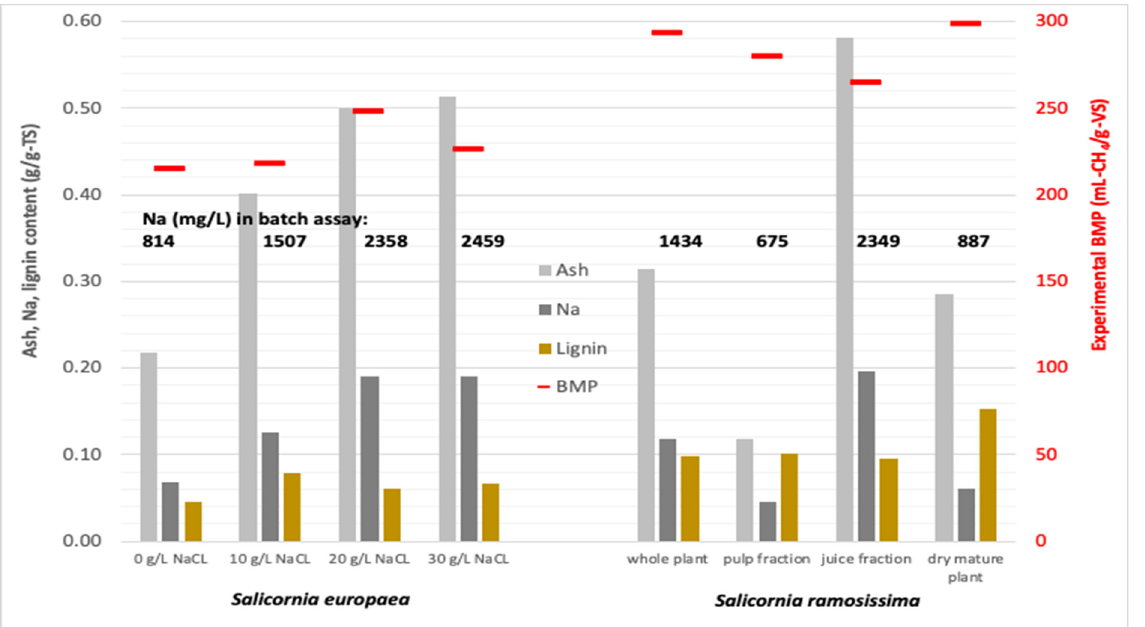
Figure 4. Experimental BMP and ash, Na and lignin content of the different samples of S. europaea and S. ramosissima .